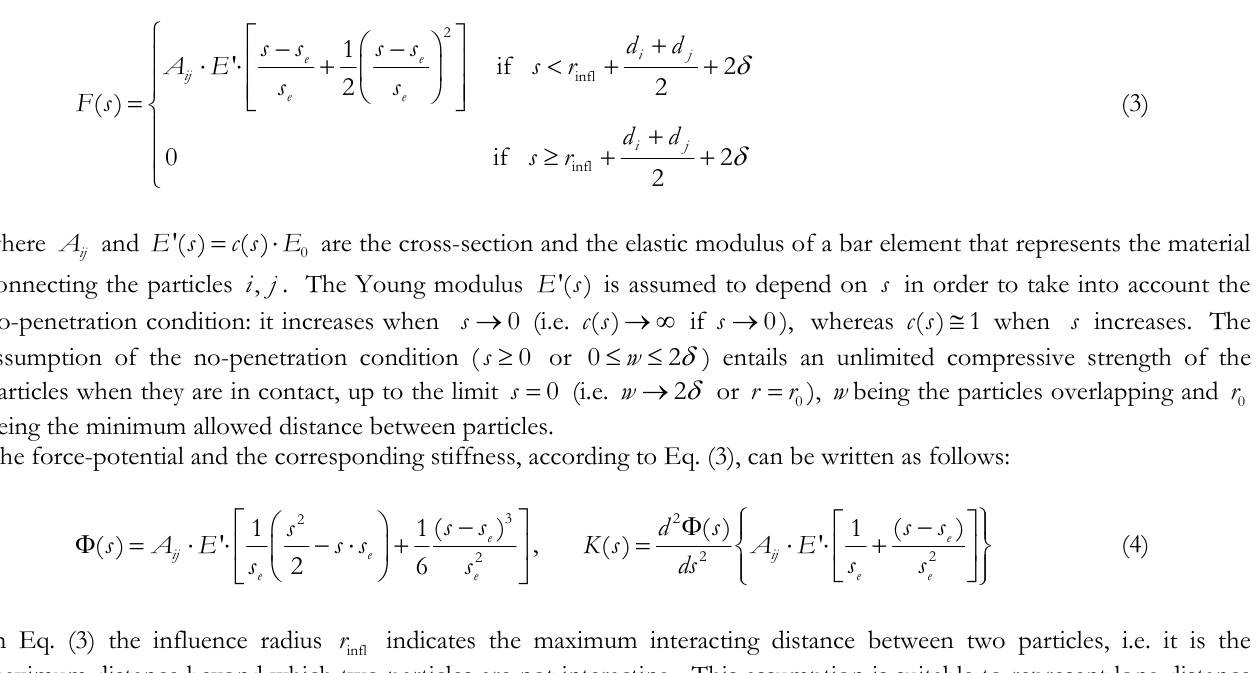
Figure 2: (a) A couple of particle at the equilibrium distance. (b) Maximum co-penetration corresponding to Generic particles relative position with geometrical